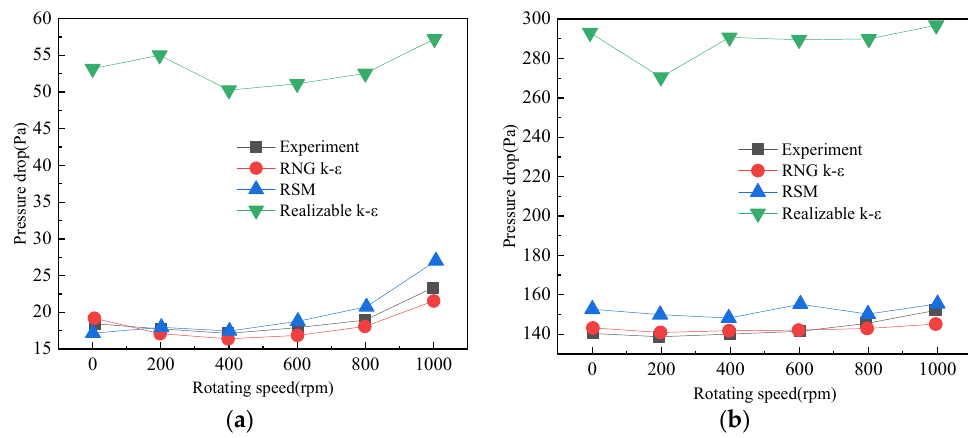
Figure 3. Comparison of the experimental total pressure drop with calculated pressure drop for three turbulence models at different gas flow rates and rotating speeds. ( a ) Gas flow rate of 200 m 3 ·h − 1 ; ( b ) gas flow rate of 800 m 3 ·h − 1 .